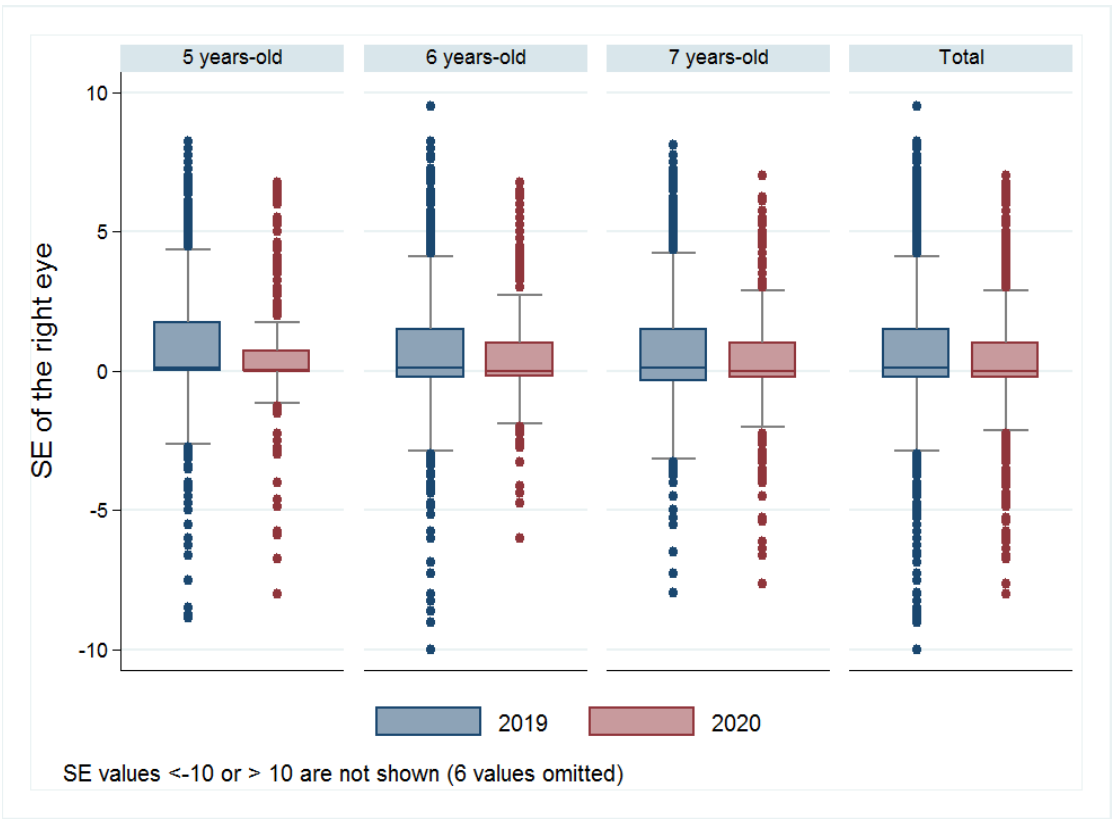
Figure 2. Spherical equivalent in 2019 vs. 2020 by ages and in all the children. The box is determined by Q1 (1st quartile) and Q3 (3rd quartile) and the whiskers are determined by Q3 + 1.5 IQR (upper whisker) and Q1—1.5IQR (lower whisker).